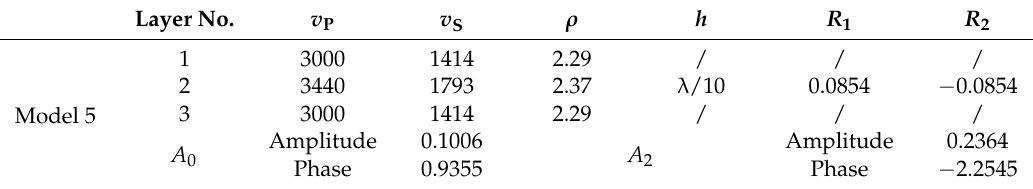
Table 2. Rock properties, A 0 and A 2 of the testing thin-bed model, units of velocities and densities are m/s and g/cm 3 , respectively.